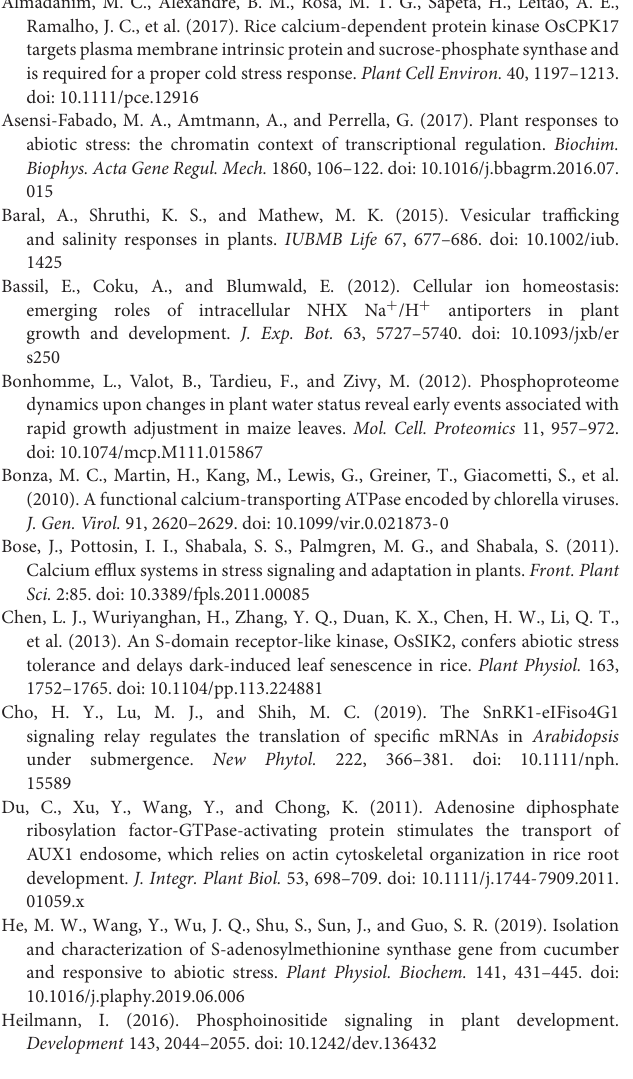
Supplementary Table 7 | GO functional cluster statistics and list of DRPPs in the biological process in four comparison groups, AN04TvsAN04C, YG2CvsAN04C, YG2TvsAN04T, and YG2TvsYG2C. Supplementary Table 8 | List of eight clusters in K-means analysis of DAPs. Supplementary Table 9 | List of eight clusters in K-means analysis of DRPPs. Supplementary Table 11 | List of salt stress regulates the phosphorylation sites on kinases in four comparison groups, AN04TvsAN04C, YG2CvsAN04C, YG2TvsAN04T, and YG2TvsYG2C. Supplementary Table 12 | List of DRPPs involved in protein-protein interaction network in Yugu2 and AN04. Supplementary Table 13 | List of key DRPPs involved in salt response in the foxtail